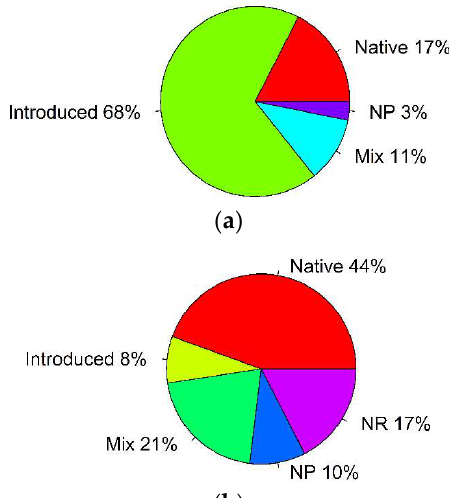
Figure 2. Percentage of studies that reported different outcomes of the feeding trials with acridid grasshoppers: (a) Most preferred plants; (b) least preferred plants (NP: No preferences observed; NR: Preferences not reported).